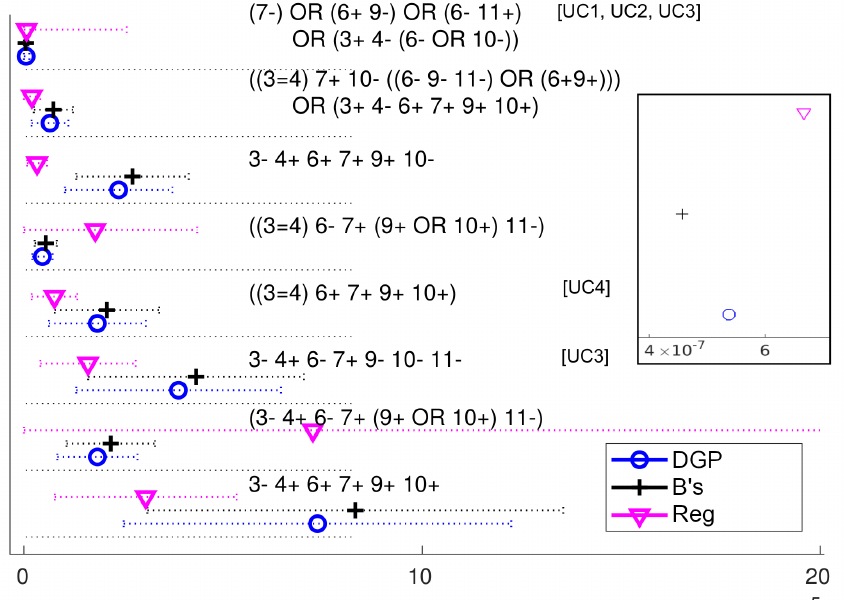
Figure A4. The eight distinctive behaviours found in the scenarios for M 3 ( α R − error ; its magnitude is in the abscissa). Right Zoom in on the first